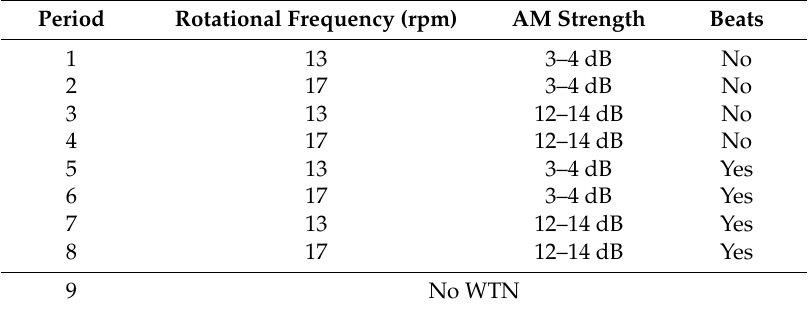
Table 4. Overview of the 400 s sound character periods within each hour in Study